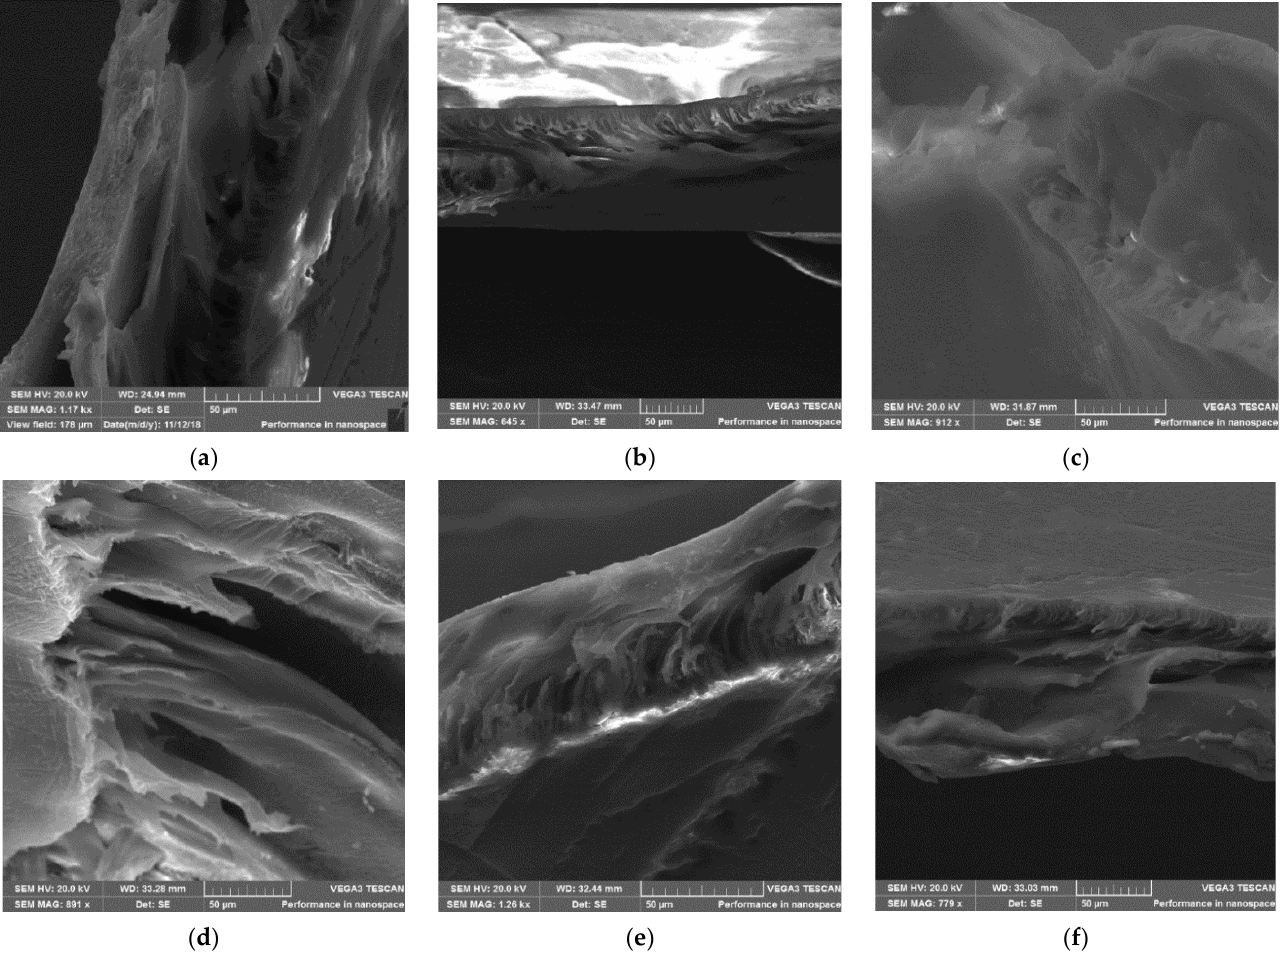
Figure 6. SEM cross-sectional of F60-ZSM-22/PES membrane materials prepared using F60-ZSM-22 as zeolite additives: ( a ) PES, ( b ) 0.1 wt.% F60-ZSM-22/PES, ( c ) 0.3 wt.% F60-ZSM-22/PES, ( d ) 0.5 wt.% F60-ZSM-22/PES, ( e ) 0.75 wt.% F60-ZSM-22/PES, and ( f ) 1.0 wt.% F60-ZSM-22/PES via phase